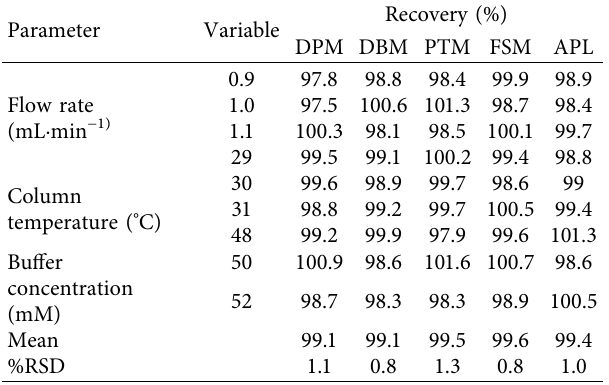
Table 4: The robustness of the proposed HPLC